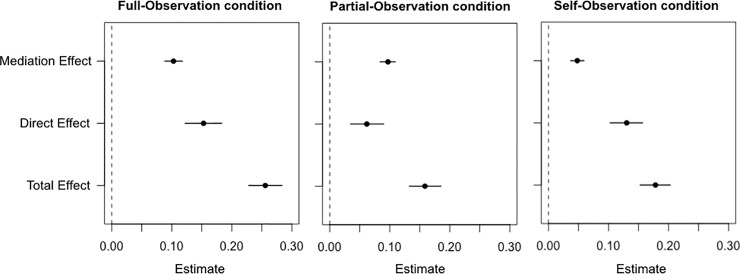
Results of the causal mediation analyses between the mediation and the outcome mixed regression models predicting the influence of the confidence of the agent on the guess of the observer through response times.Error bars reflect quasi-Bayesian 95% confidence intervals.